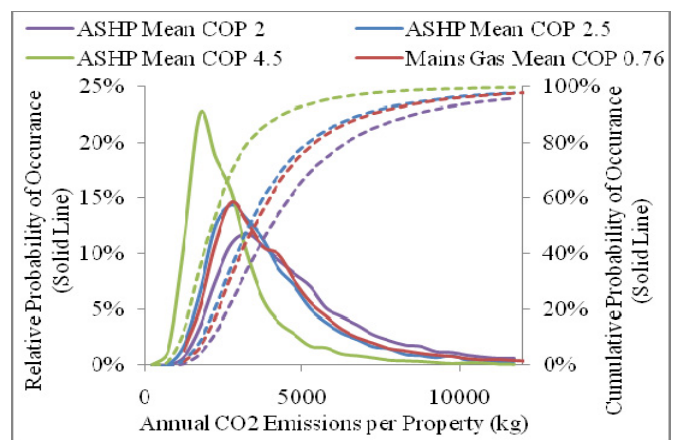
emissions for ASHPs. 2